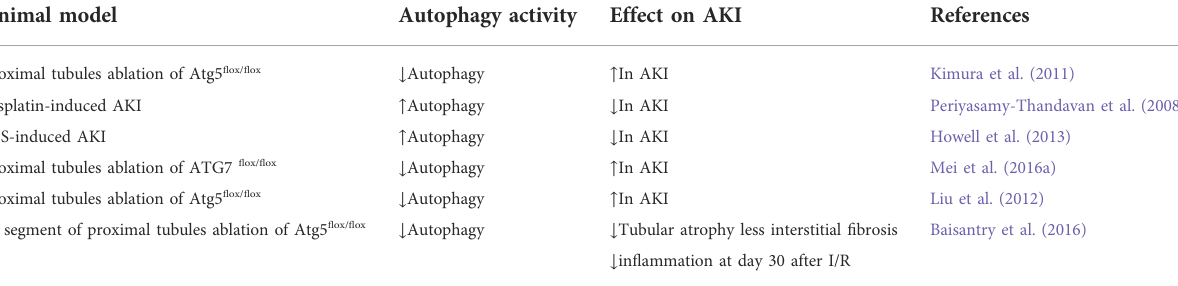
TABLE 1 Effects of autophagy on